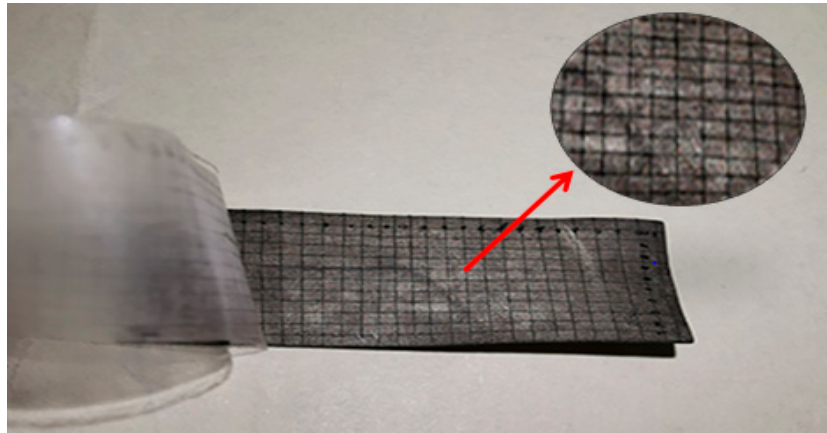
Figure 4. Adhesive force of the sample L4.